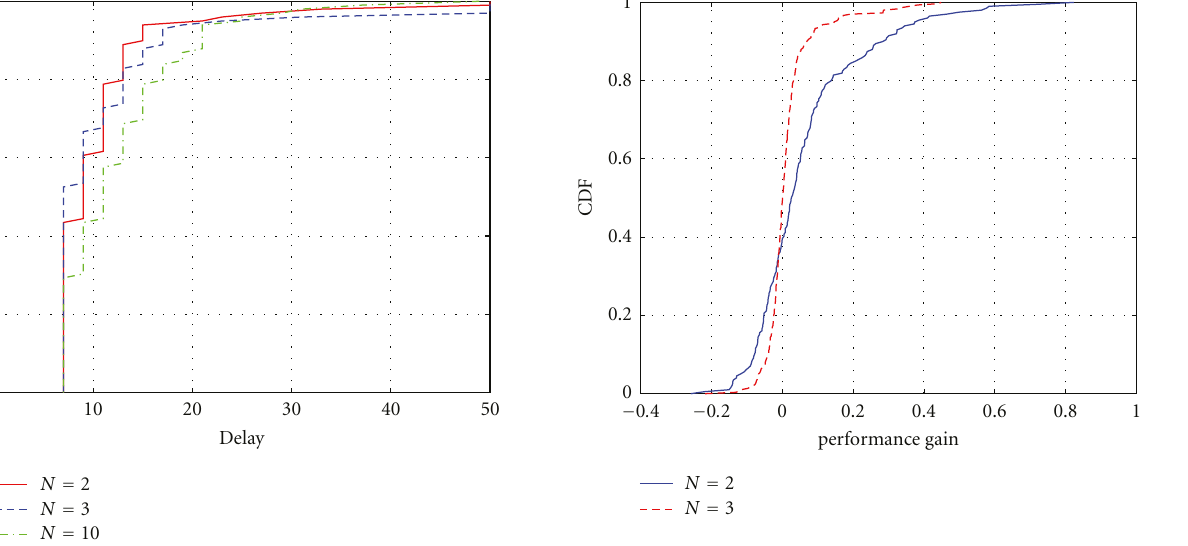
Figure 13: CDF of learning delay when the system state is fully observable.